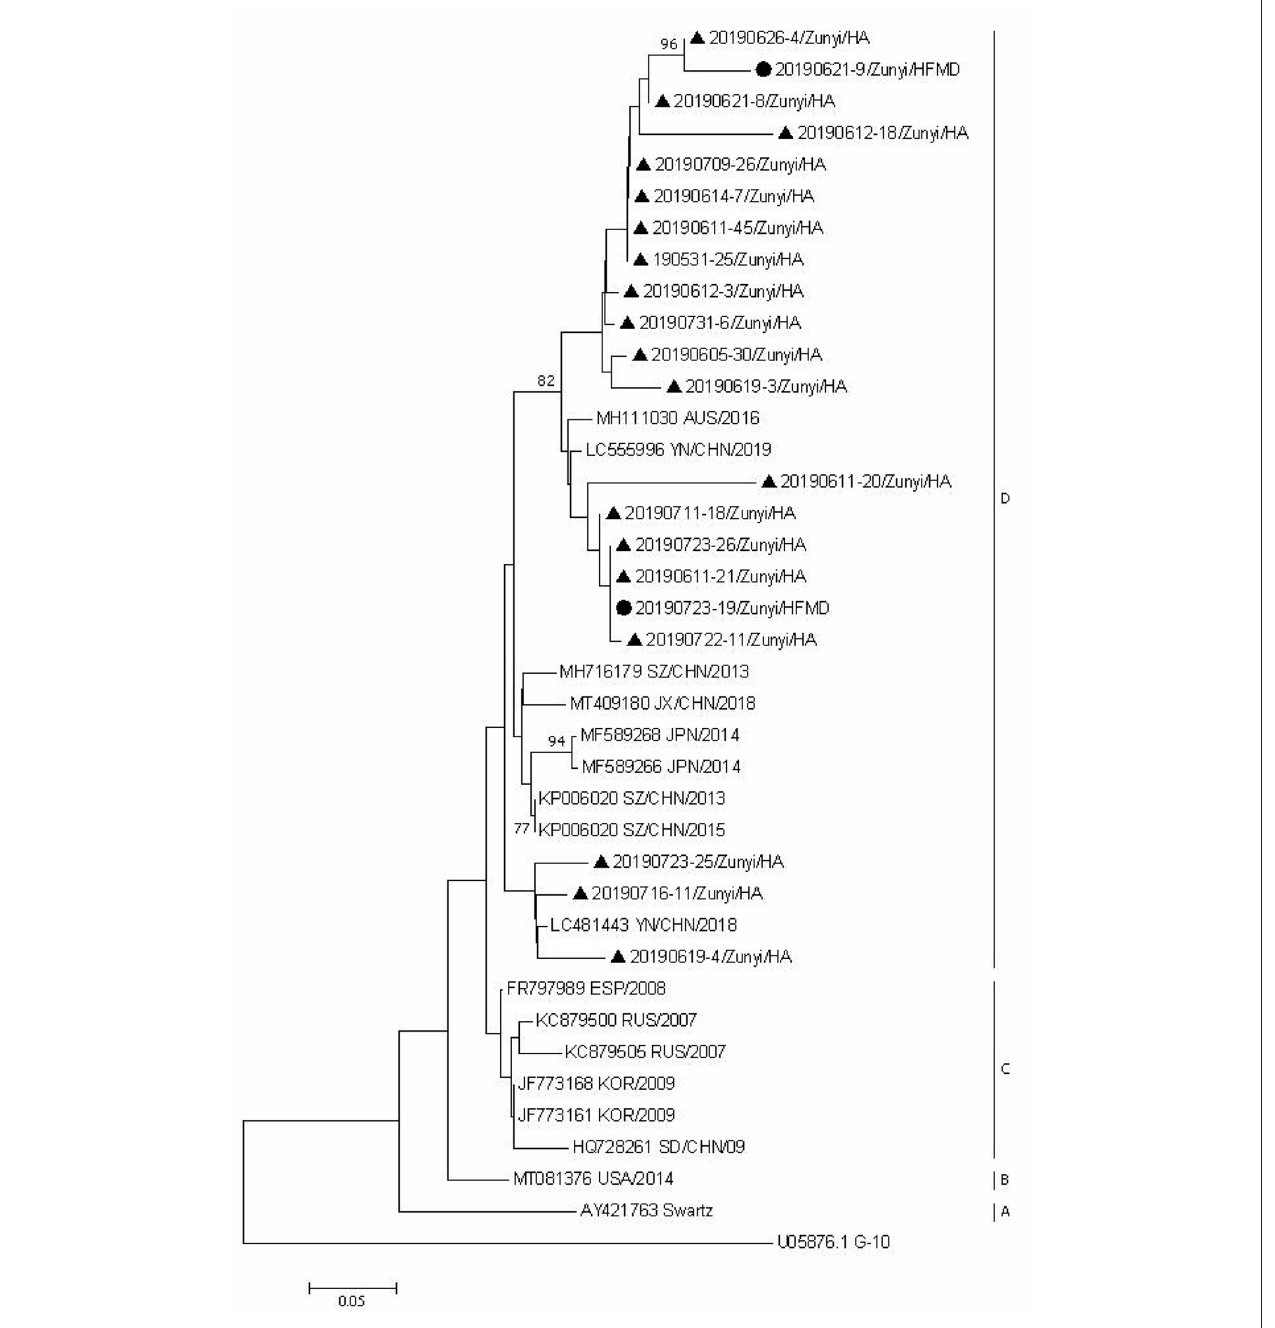
FIGURE 5 | Phylogenetic analysis of CVA5 based on partial VP1 gene sequence. Strains identified from HFMD are marked by circle, and those identified from HA are marked by triangle.